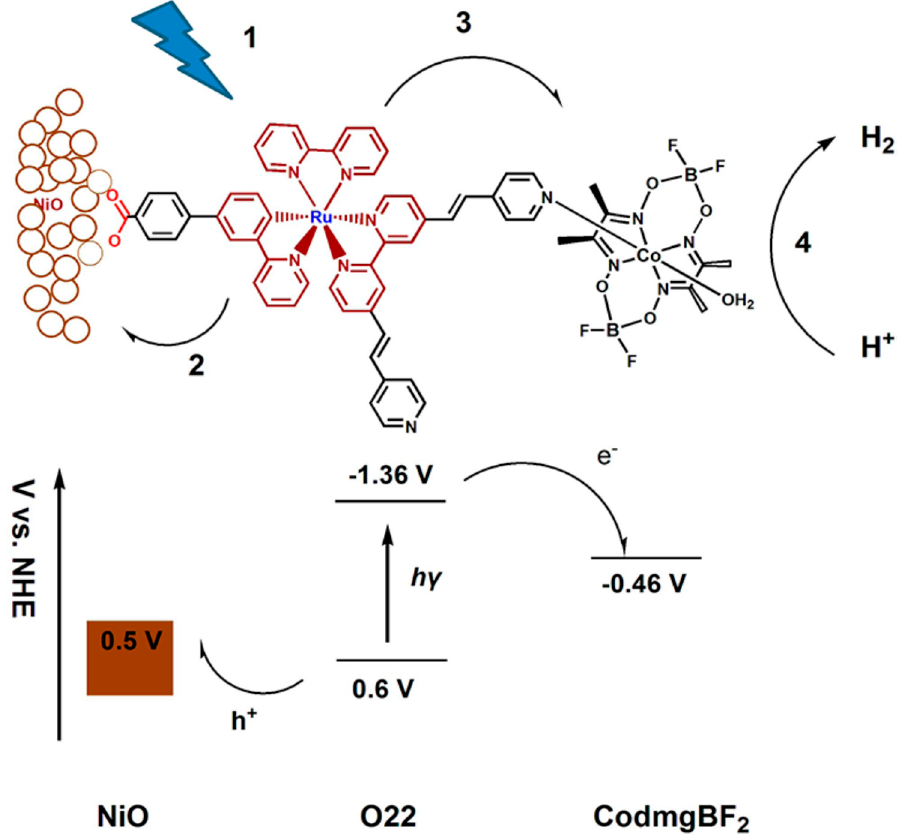
Figure 11. Energy diagram and scheme of the photoactivated overall process of ET from NiO to H + . The Ru ‐ complex O22 immobilized on NiO surface is the dye ‐ sensitizer acting as an electron donor towards the co ‐ catalyst CodmgBF 2 , and as an electron acceptor from NiO. The Co center of CodmgBF 2 complex is coordinated by a pendant pyridine group of O22. Reproduced with permission from reference [74].